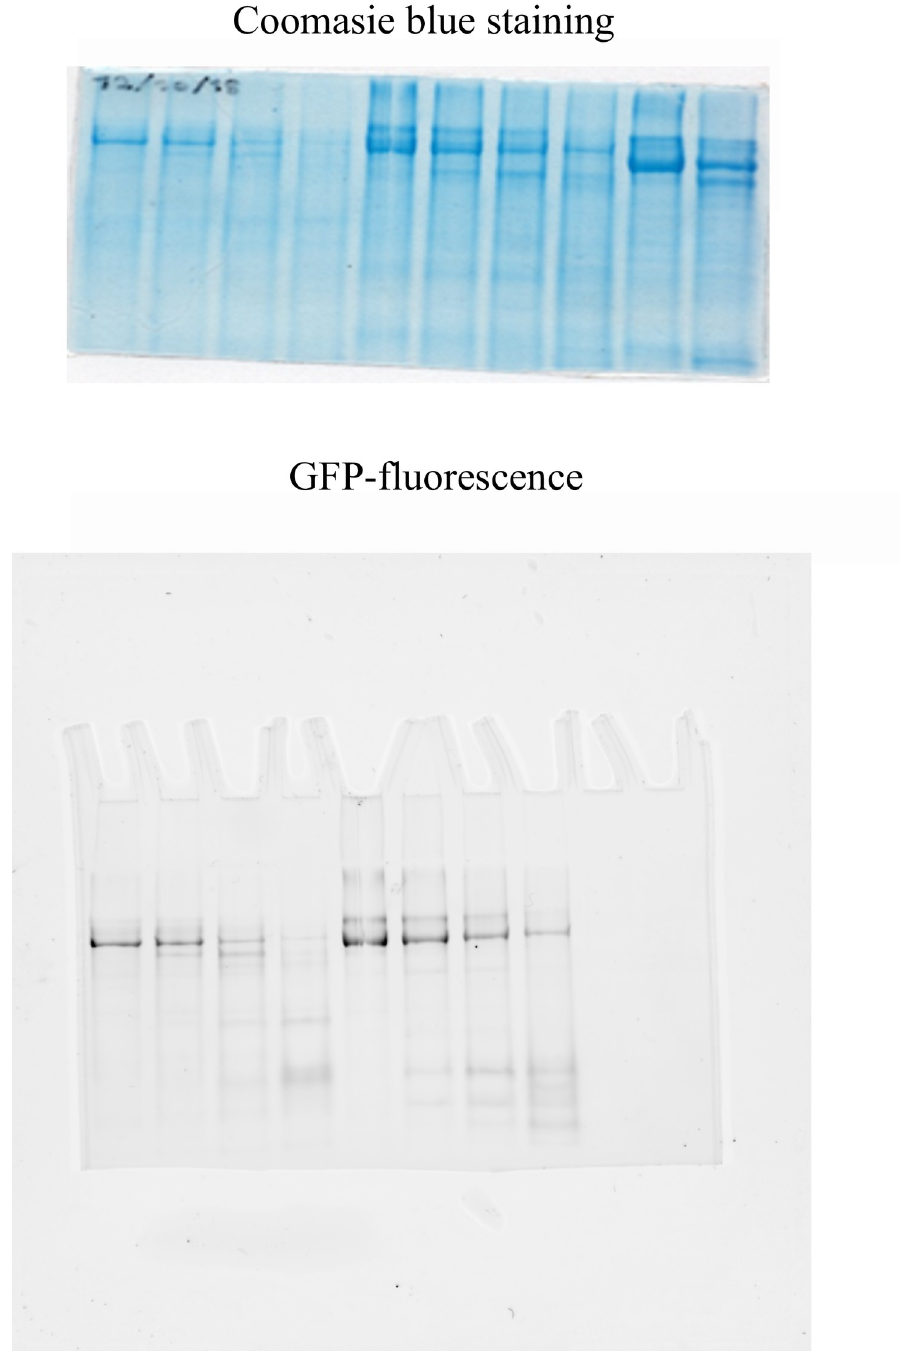
Fig 3. Comparison of the chymotryptic digestion pattern of GFP-Spf1, Spf1p-GFP and Spf1p. Spf1p and the Spf1p GFP fusion protein indicated in the figure were digested with chymotrypsin at a ratio protein: protease (w/w) of 20:1. After the time indicated on top of each lane, the proteolysis was stopped by adding 5 μ g of aprotinin. The samples were electrophoresed in a 9% SDS-PAGE and revealed by Colloidal Coomassie staining ( left panel ) or GFP fluorescence ( right panel ). The arrows indicate the migrations of the GFP-Spf1p fragments produced by the cut at Chy1 and the equivalent non-fluorescent fragment generated from Spf1p-GFP and Spf1p.